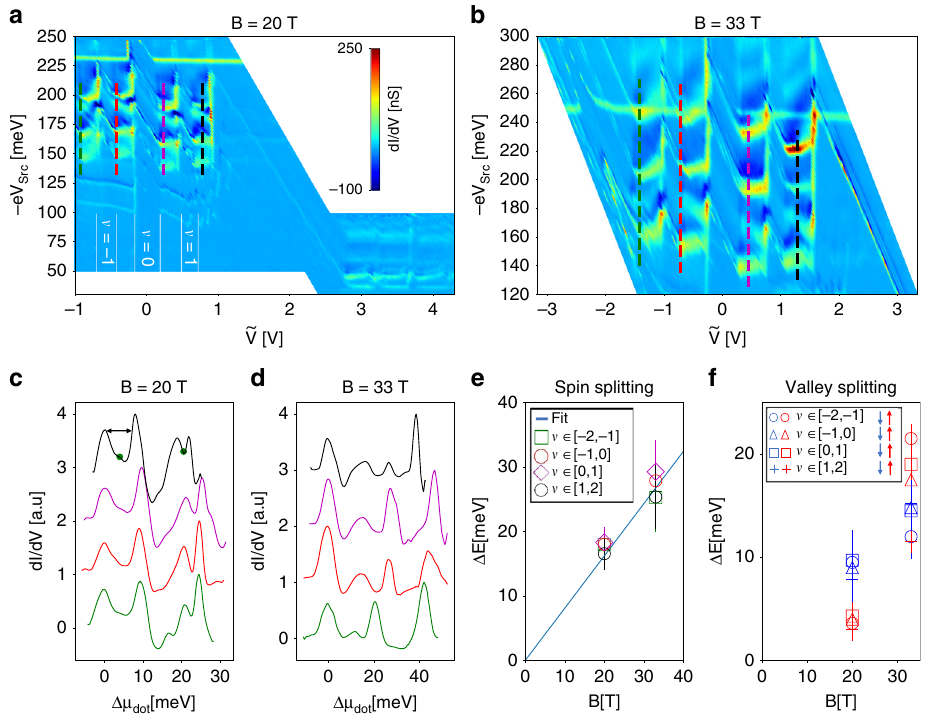
Fig. 4 Degeneracy Lifting at High Fields. a ( N I = 1, N G = 0) (upper left) and ( N I = 1, N G = 1) (lower right) at B = 20 T. Splitting along the ~ V axis corresponds to degeneracy lifting of the ground state, while splitting along the − e V S rc axis corresponds to splitting of the injection state. Regions of integer fi lling factor are marked. b ( N = 1, N = 0) at B = 33 T. c , d d I /d V vs. dot energy along the colored lines in a , b . The means of the low and high bias pairs of I G peaks are marked by green dots. The energy difference within each pair is marked by the double-headed arrow. e The energy difference between the mean of the low and high energy two peaks, for every colored line ( fi ll factor) in panels a,b. Error bars correspond to half the peak width. The differences are plotted along a linear fi t to the Zeeman energy splitting with a fi t to g = 14 ± 1. f The energy difference between same-spin peaks vs. B . Blue markers indicates the down-spin peaks, and red markers indicate the up-spin